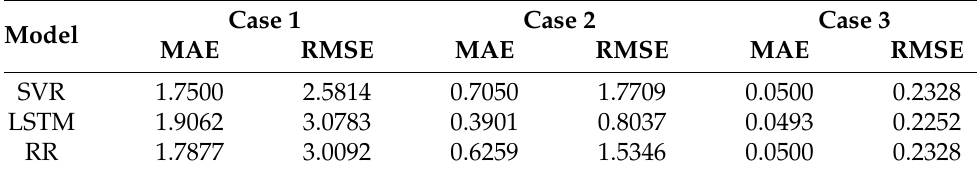
Table 3. Average error of models.